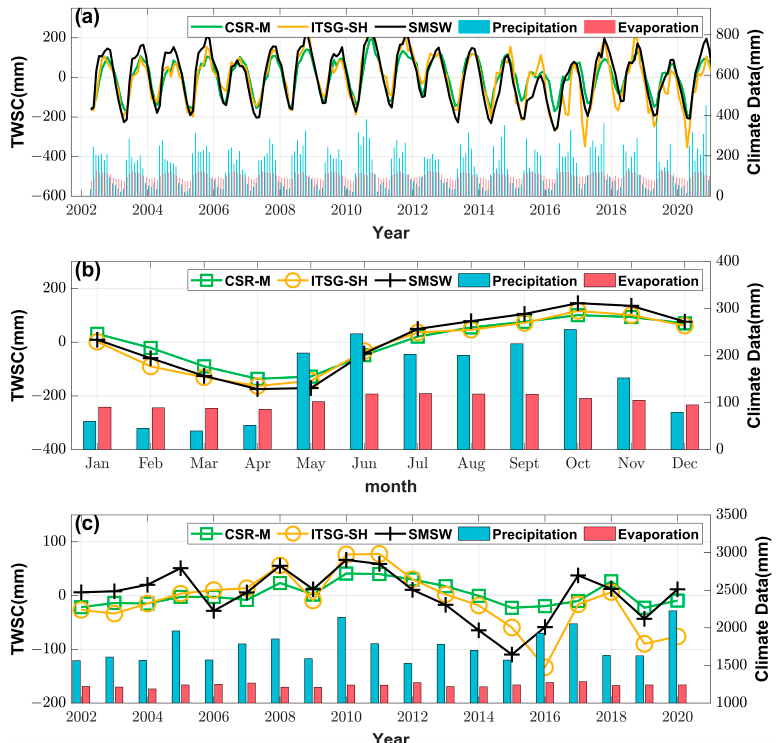
Figure 4. ( a ) Monthly variation, ( b ) mean annual cycle, and ( c ) annual variation in TWSC changes (CSR-M, ITSG-SH, and SMSW) and climate data (precipitation and evaporation). The annual variation in climate data is an accumulation of one year. The annual variation in TWSC is a mean value of one year.